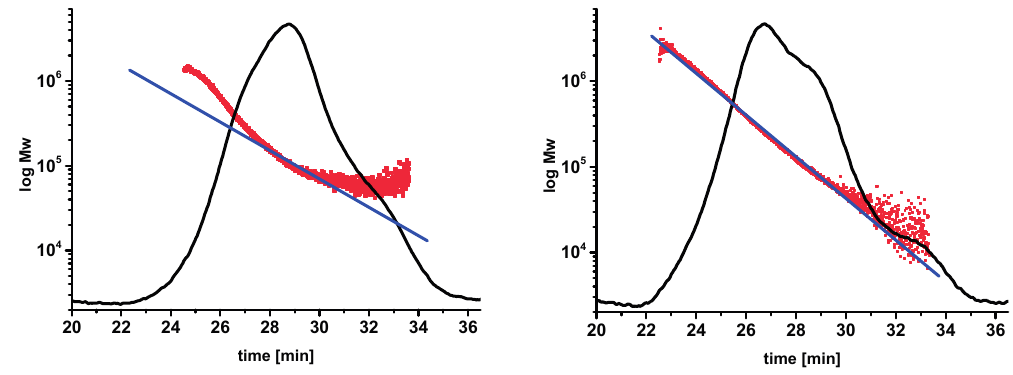
Figure 2. SEC-MALLS chromatograms of the same sample dissolved individually. The chromatogram on the left shows a poor state of dissolution; the chromatogram on the right depicts a satisfactory state of dissolution of the polymer. The red dots represent a light scattering signal; the blue lines represent a fitted (linearized) light scattering signal